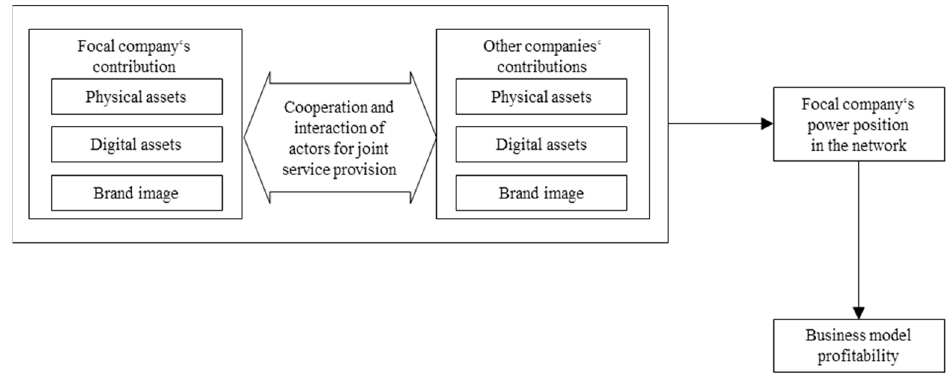
Figure 4. Presumed relationship between a company’s power position and business model profitability (own figure).